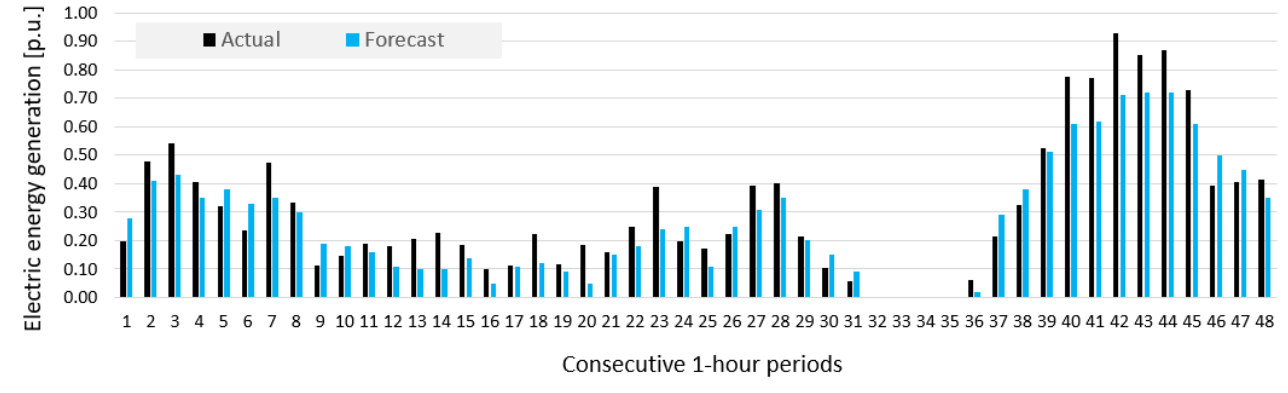
Figure 20. Two forecasts of electric energy generation for Wind Farm A made by INT_OUT_EXT [GBT, RF, PHYS(v1&v2) → KNNR, MLP, LSTM] method with additional expert correction for two consecutive days of the summer month (August). Energies 2022 , 15 , x FOR PEER REVIEW